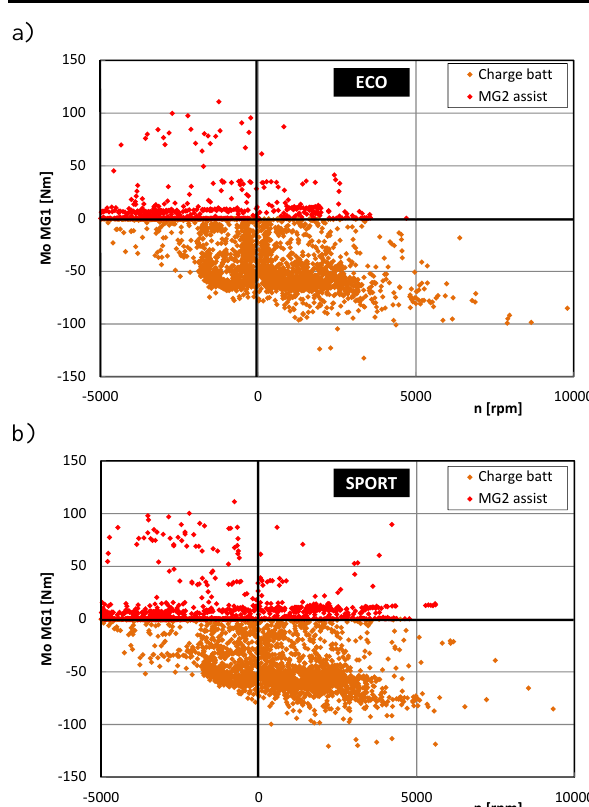
Fig. 13. Operating conditions of the MG1 electric motor in two driving modes: a) ECO, b) SPORT